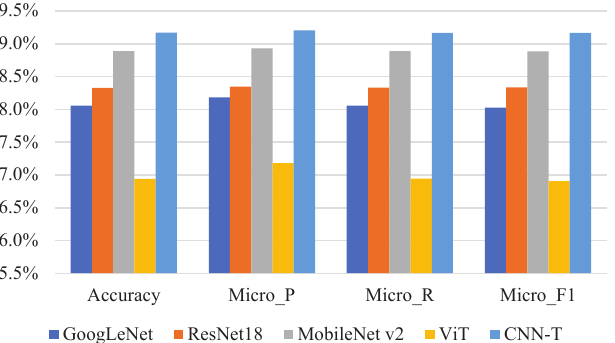
Figure 9. Accuracy, precision, recall, and F1 of CNN-T and reference models when the training ratio is